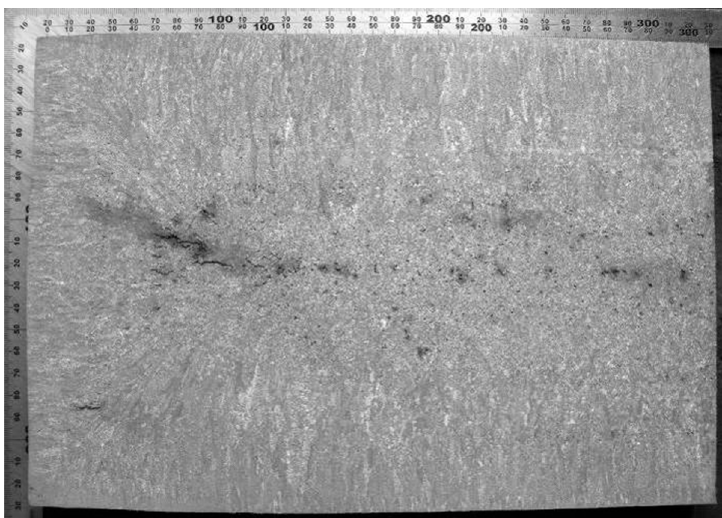
Figure 12. Macrosegregation examination of the results of the traditional method.